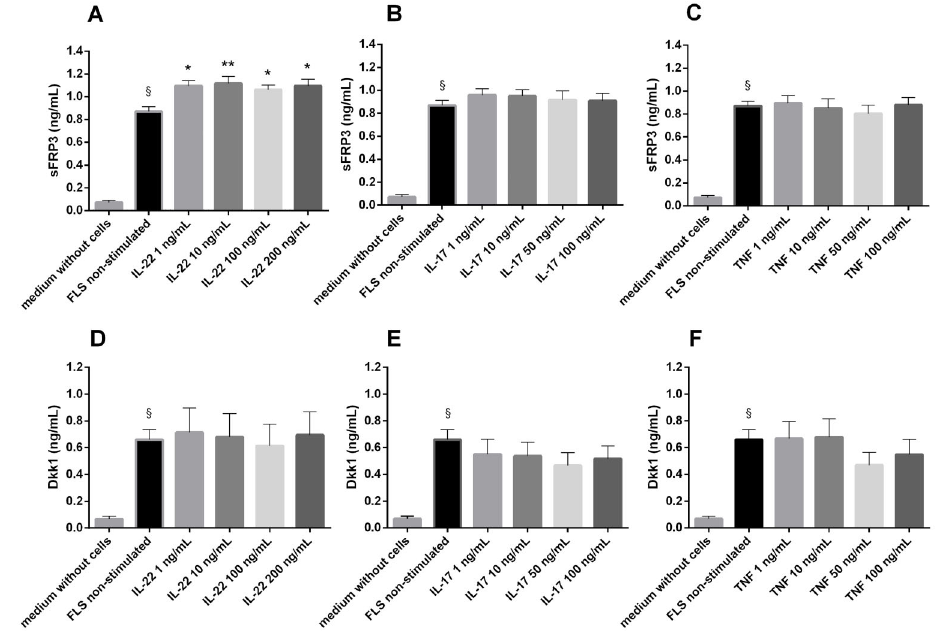
Figure 2. Wnt inhibitor expression by fi broblast-like synoviocytes (FLS) after different cytokine stimuli. Secreted Frizzled-related proteins (sFRP3)/FRZB ( A – C ) and Dickkopf-related protein 1 (Dkk1) ( D – F ) concentrations measured in the FLS culture supernatant (n=3) after different stimuli (interleukin (IL)-17, IL-22, and tumor necrosis factor (TNF)- a ) and in controls. Data are reported as mean( ± SE) from three independent repetitions. y P o 0.0001 ( vs medium without cells). *P o 0.05 and **P o 0.01 (stimulated vs non-stimulated FLS) (ANOVA).